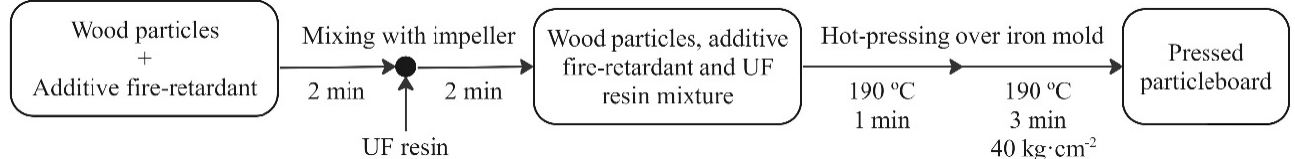
Scheme 3. Flowchart of the preparation of FR-containing particleboards. Table 2. Composition of the different mixtures used for lab particleboards and final thickness and